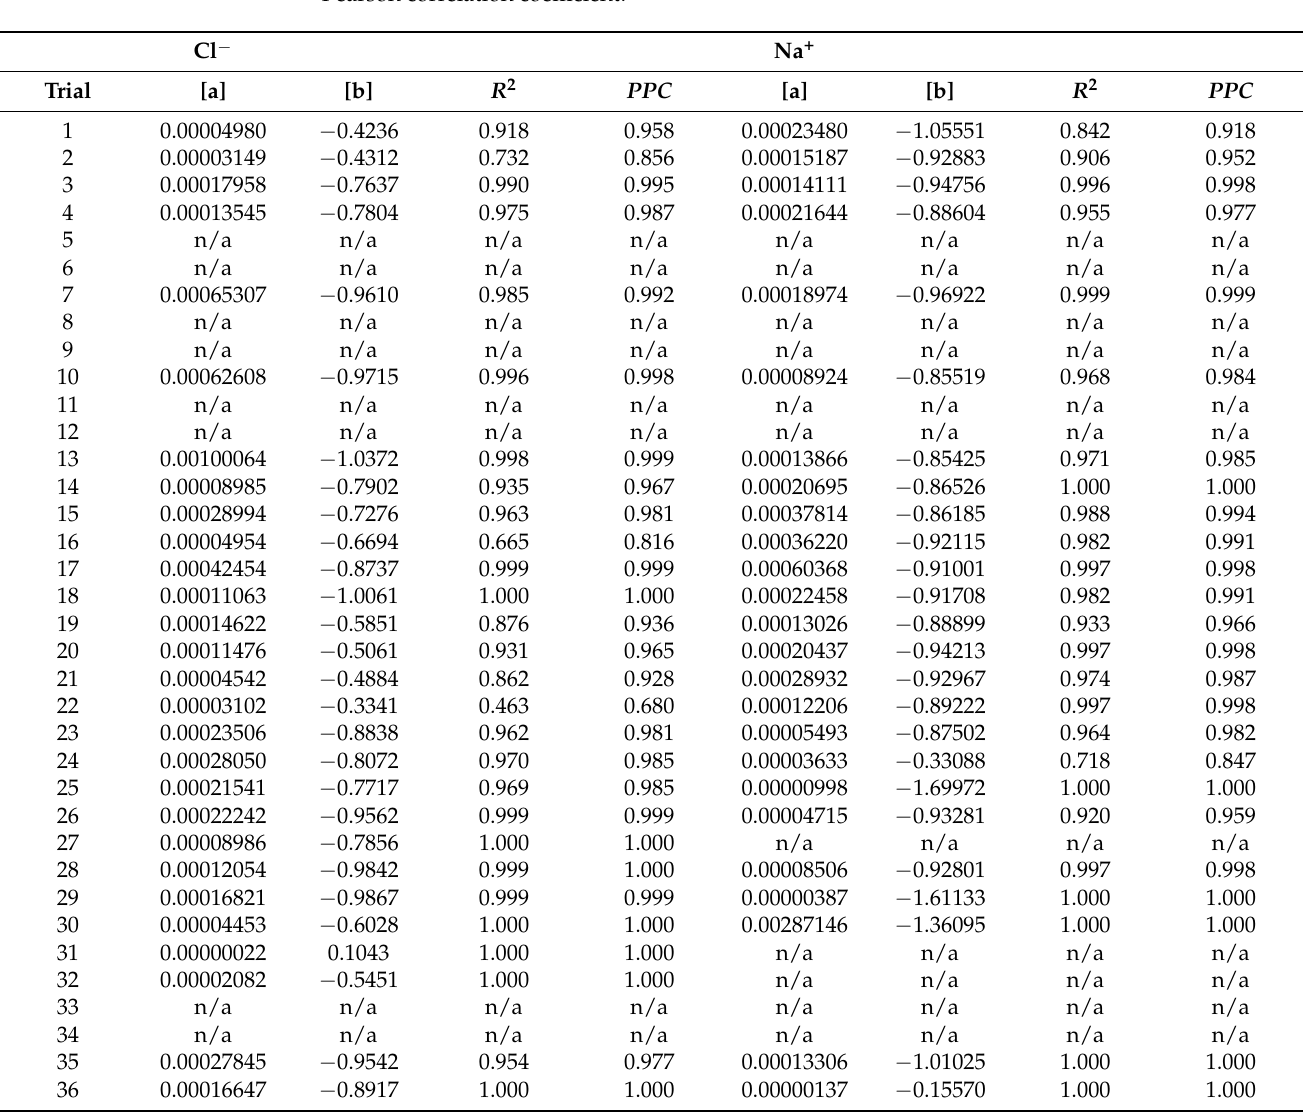
Table A5. Measured values of [a], [b], and R 2 associated with ion removal in Trials 1 to 87, Table A1, Table A2, Table A3, and Table A4. Values calculated from a regression plot of k obs vs. reaction